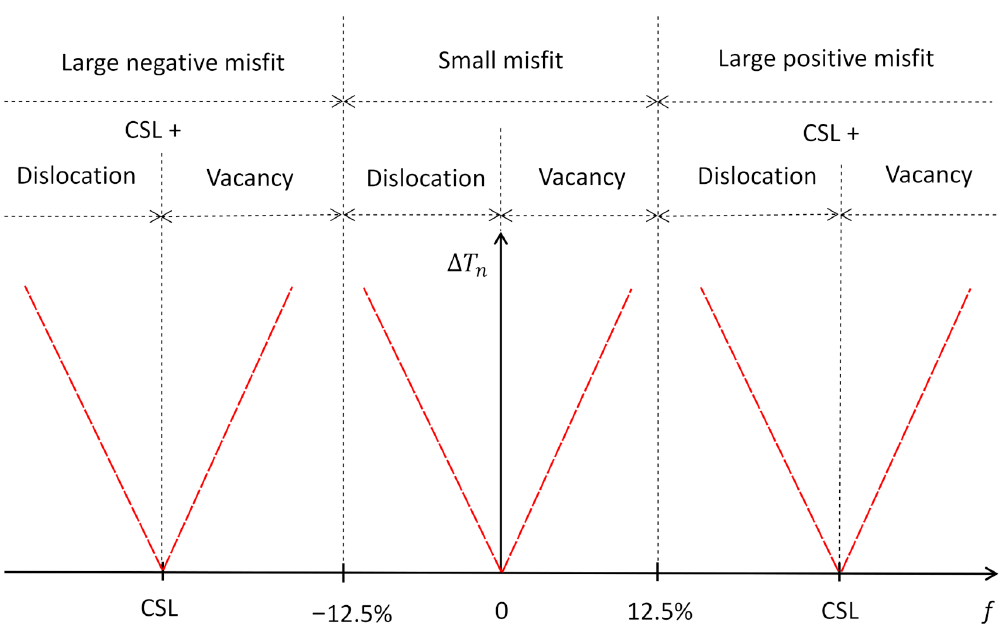
Figure 25. Summary of nucleation mechanisms. Schematic illustration of mechanisms for accommo- dating lattice misfit and nucleation undercooling ( ∆ T n ) as a function of lattice misfit ( f ). For systems with small negative misfit ( − 12.5% < f < 0), nucleation takes place through a three-layer dislocation mechanism; for systems with small positive misfit (0 < f < 12.5%), nucleation takes place through a three-layer vacancy mechanism; for systems with large misfit (| f | > 12.5%), nucleation takes place by two distinctive steps: (1) prenucleation creates CSL to accommodate the majority of the misfit ( f csl ); and (2) heterogeneous nucleation at the nucleation temperature to create a 2D nucleus through either a three-layer dislocation mechanism if the residual misfit is less than 0 or a three-layer vacancy mechanism if the residual misfit is larger than